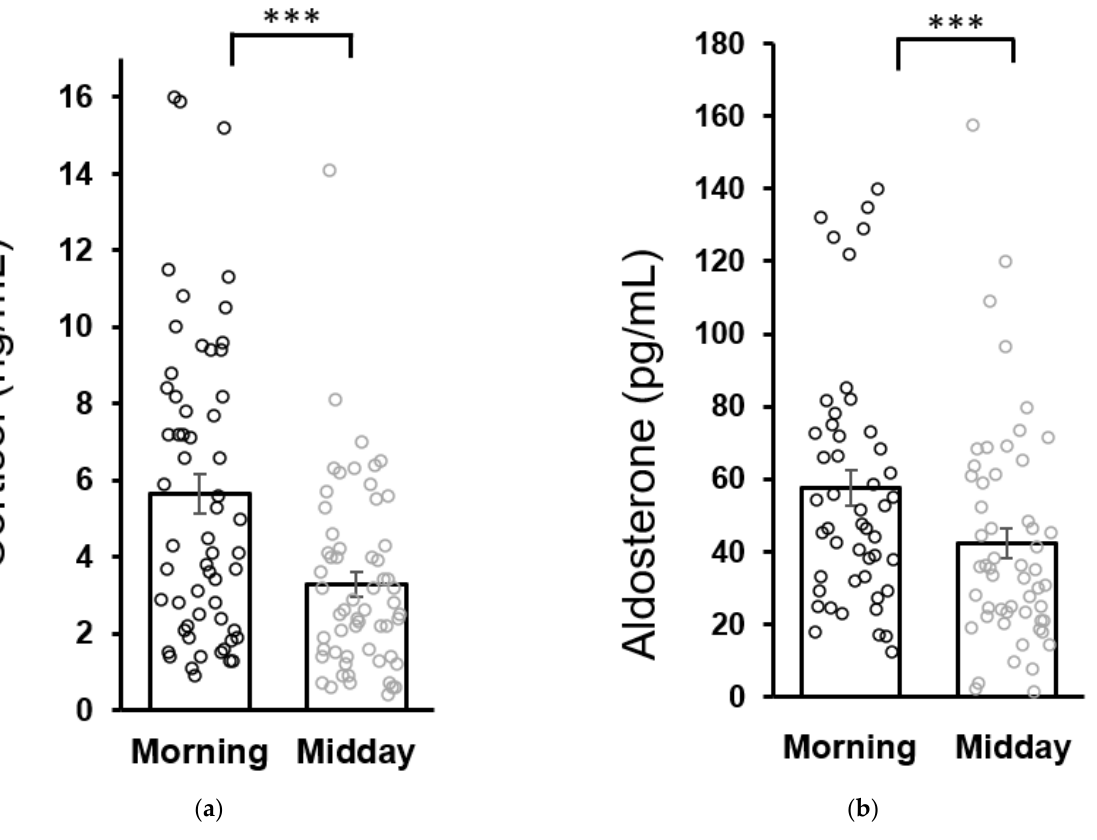
Figure 2. Circadian variation of salivary cortisol ( a ) and aldosterone ( b ) secretion in patients at the baseline (week 0). Statistical significance as revealed by Wilcoxon test: *** p < 0.001. Results are expressed as dot plots with each dot representing an individual subject with means ± SEM represented by horizontal lines.